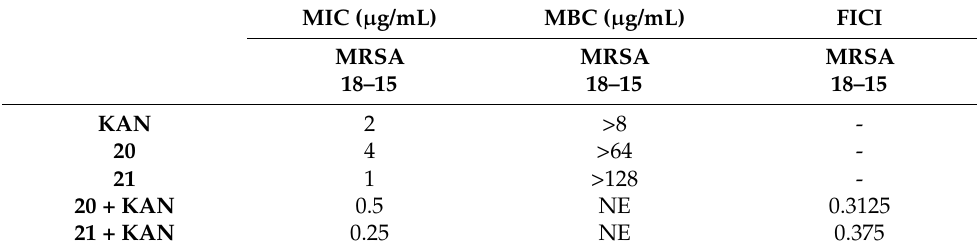
Table 3. Synergistic effect of KAN with compounds 20 and 21 against MRSA